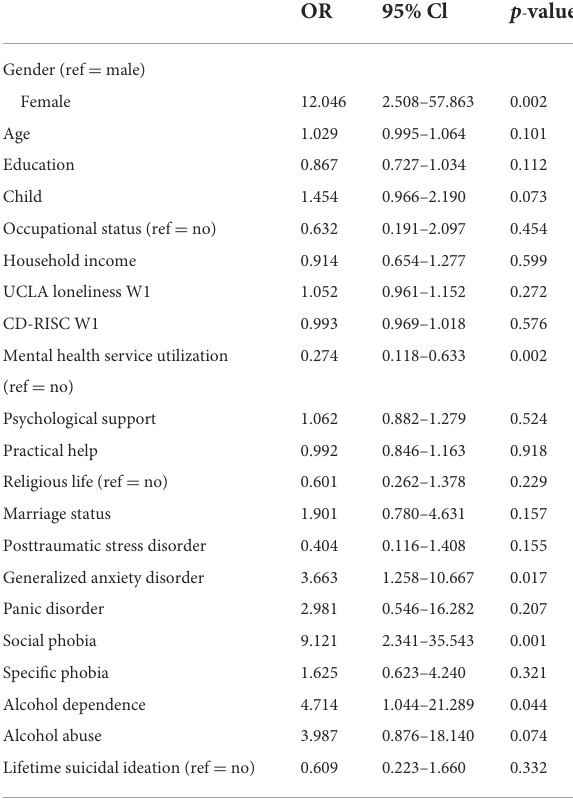
TABLE 5 Logistic regression of factors predicting high/increasing depressive trajetory